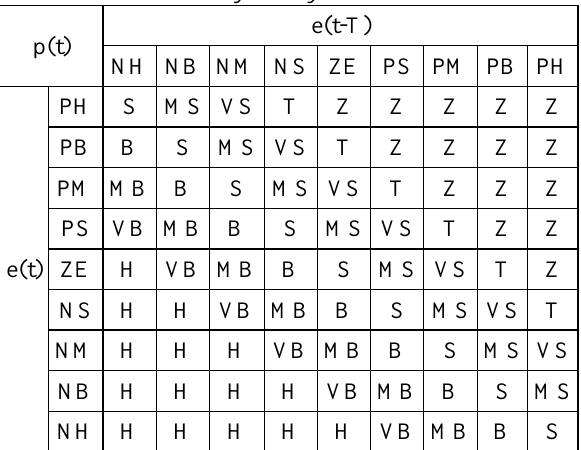
Table 2. Fuzzy rule system of